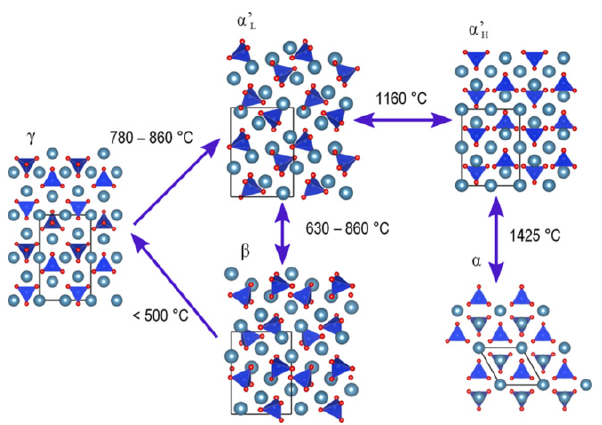
Figure 1. C 2 S polymorph structures along with the experimental ordering and temperatures of phase transitions [19], adapted from [19], with permission from ACS, 2021.